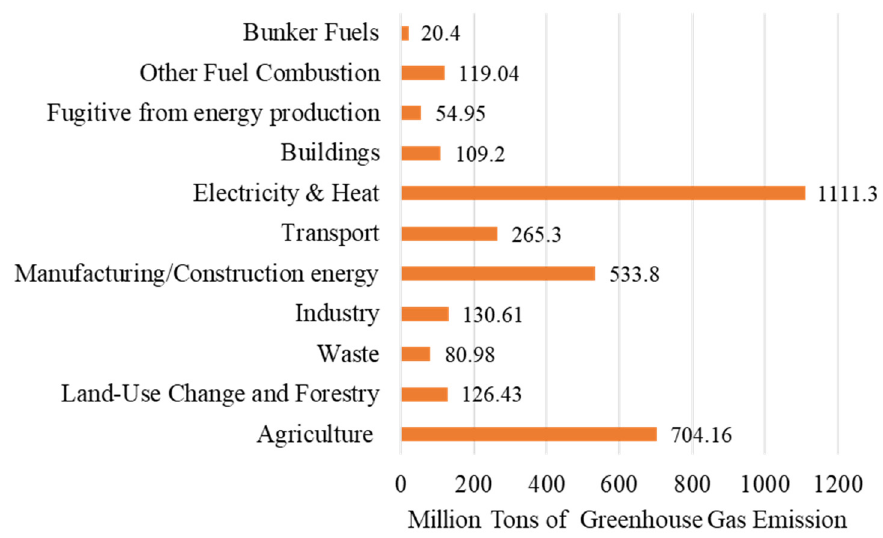
Figure 12. Sector wise greenhouse gas emissions, India, 2016. Data Source: https://ourworldindata.org/energy (02/04/2021).